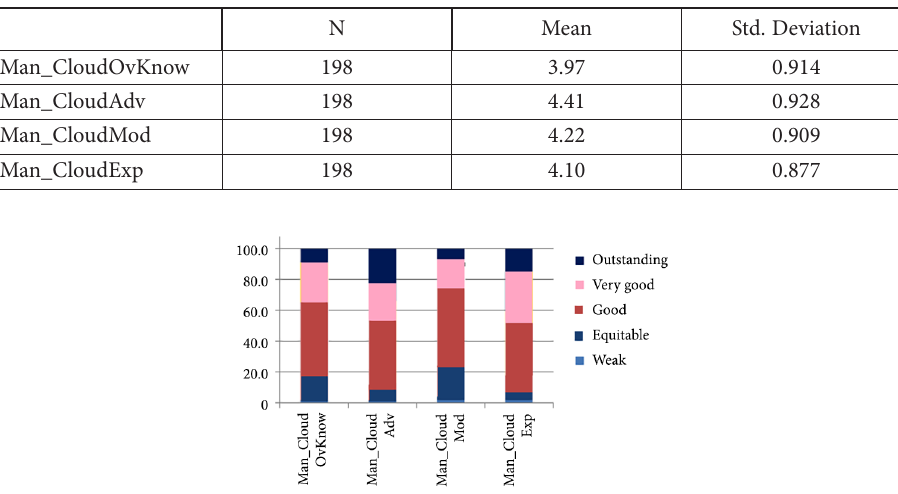
Figure 7. Respondents’ viewpoints regarding the variable managers’ cloud expertise